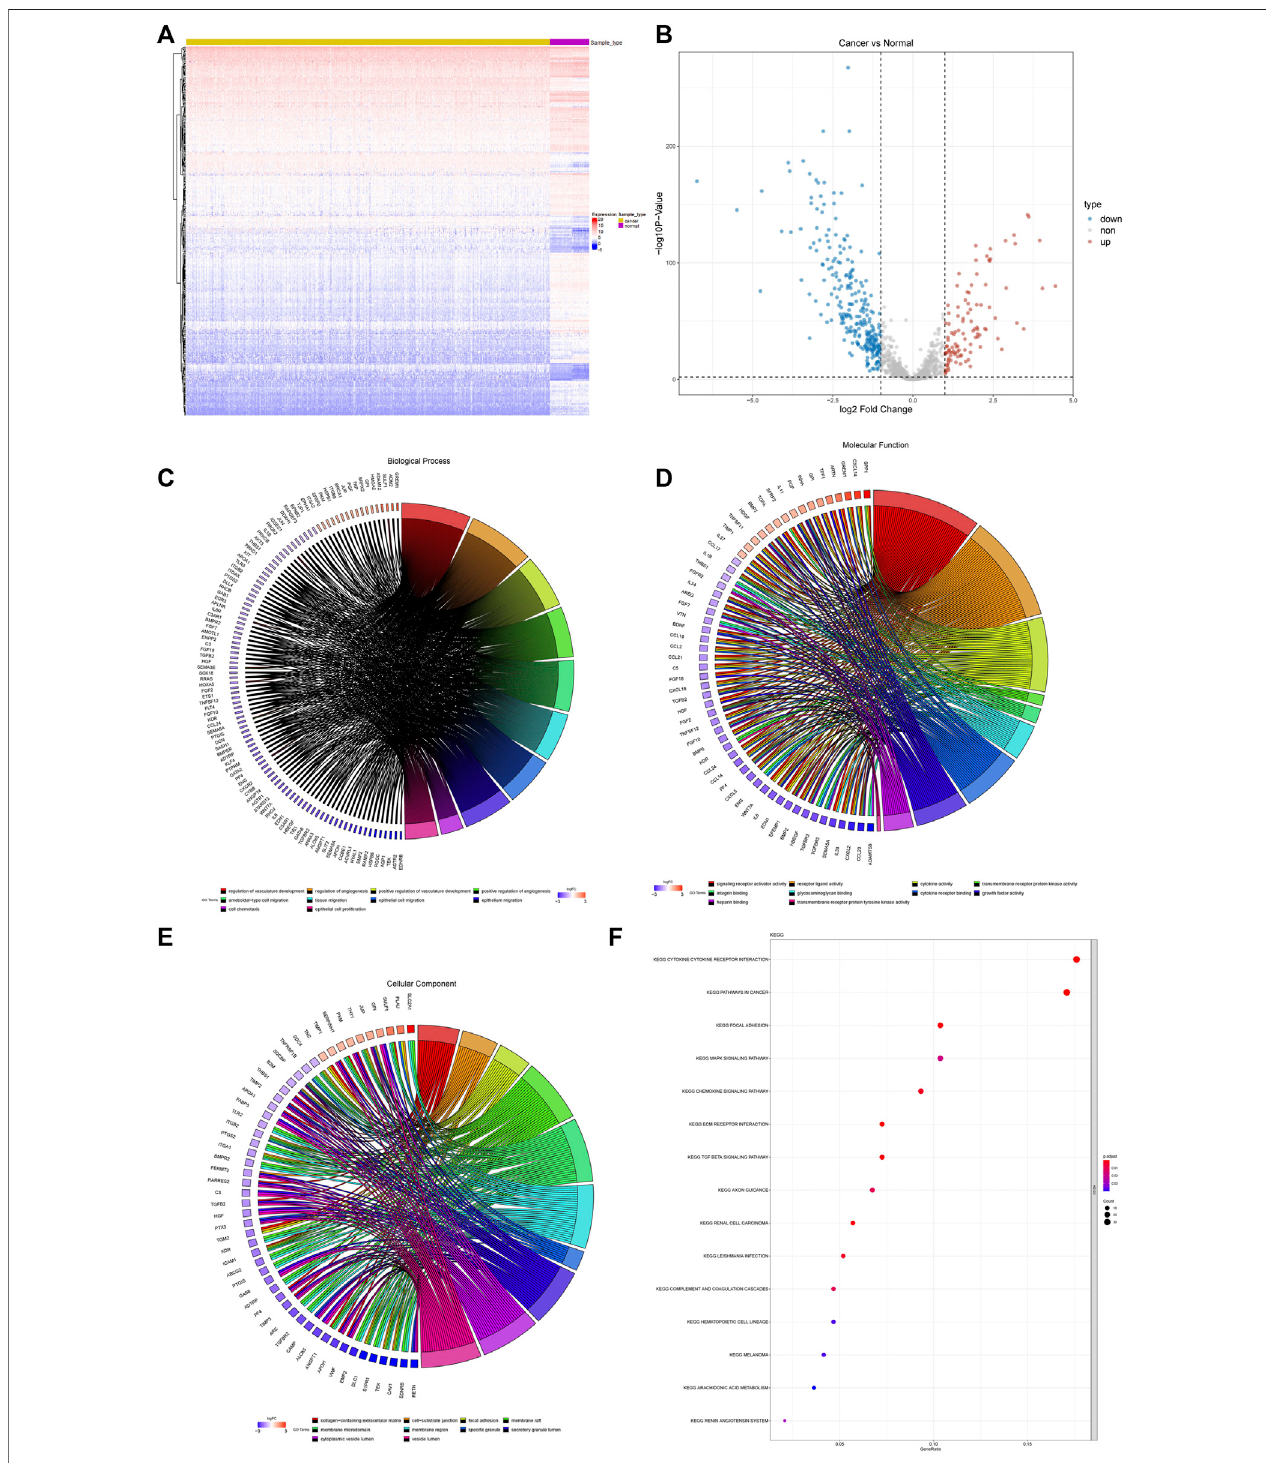
FIGURE 2 | Differential expression and functional enrichment of AF genes in non-small-cell lung cancer. (A) Heatmap and clustering of differentially expressed AF genes. (B) Volcano map of differentially expressed AF genes. (C) GO biological processes (D) GO molecular functions (E) GO cellular components and (F) KEGG.